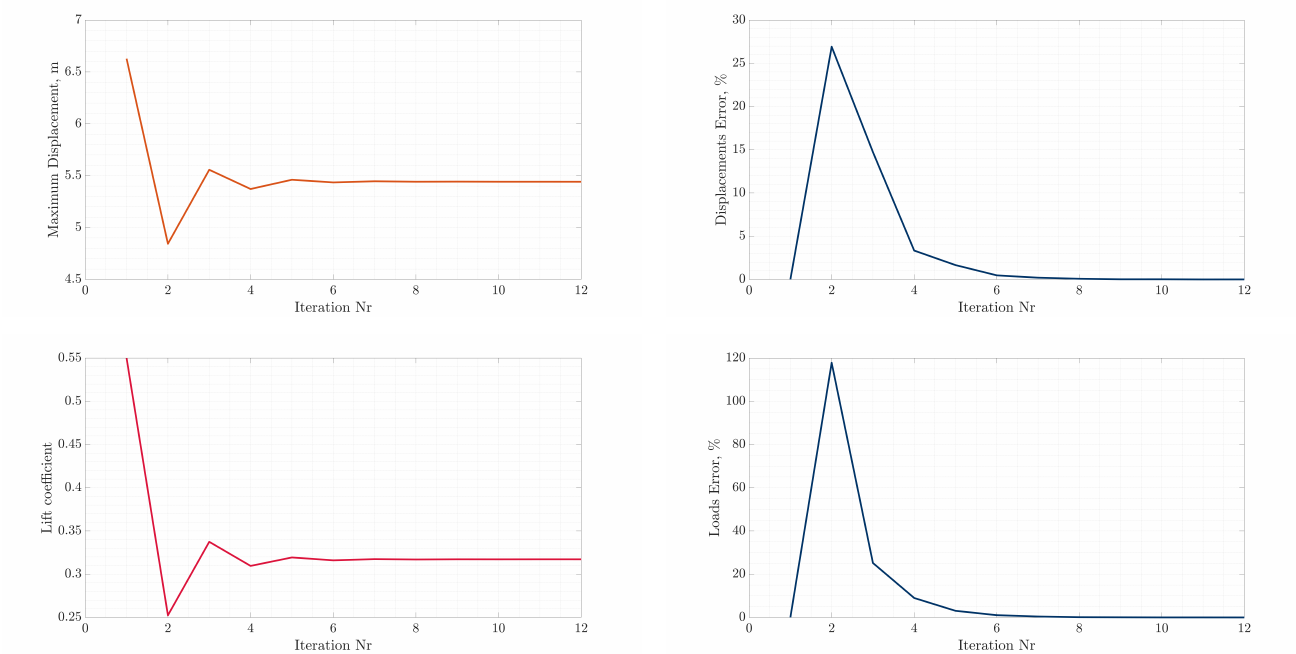
Figure 9. Displacements and lift coefficient convergence characteristics for a URF value of